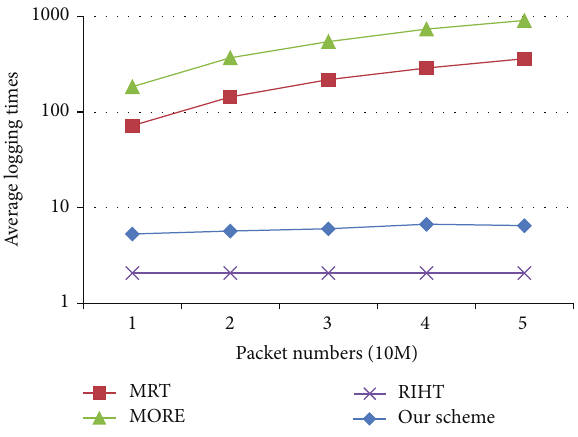
Figure 7: Comparison of logging times.